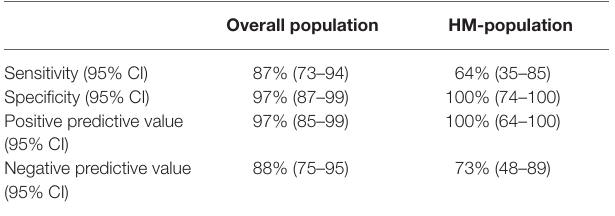
TABLE 6 | Performance of (1,3)- β -D-glucan assay for Pneumocystis pneumonia diagnosis in overall non-HIV-infected immunocompromised population and in population of patients with hematological